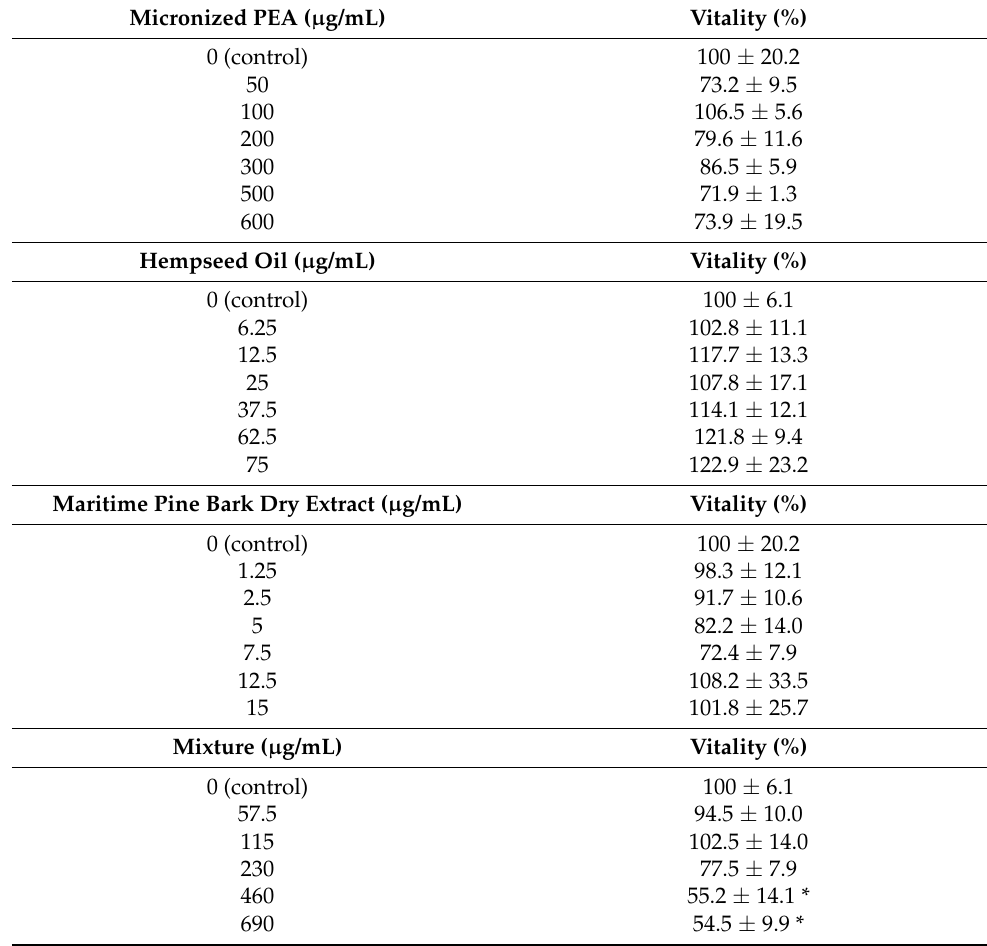
Table 1. Vitality of differentiated THP-1 cells after treatment with different concentration of mi- cronized PEA, hempseed oil, maritime pine bark dry extract, and their mixture. * vitality <